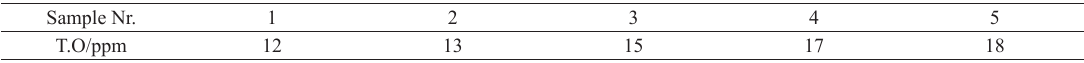
Table 4. The T.O content of the five steel samples at the end of LF process (ppm). Sample Nr.